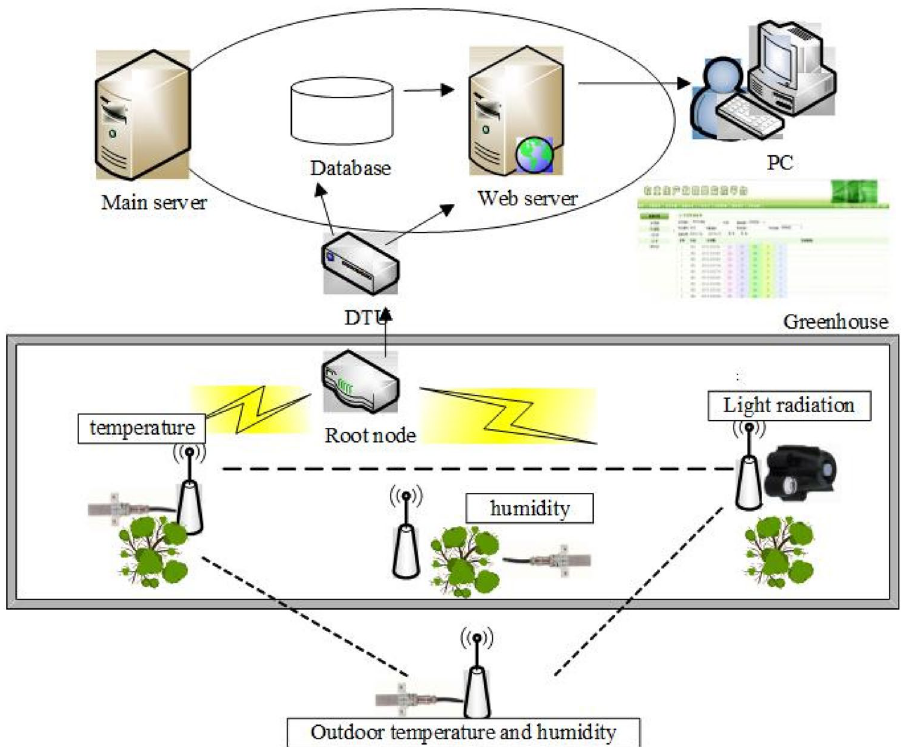
Figure 1. Experimental data acquisition